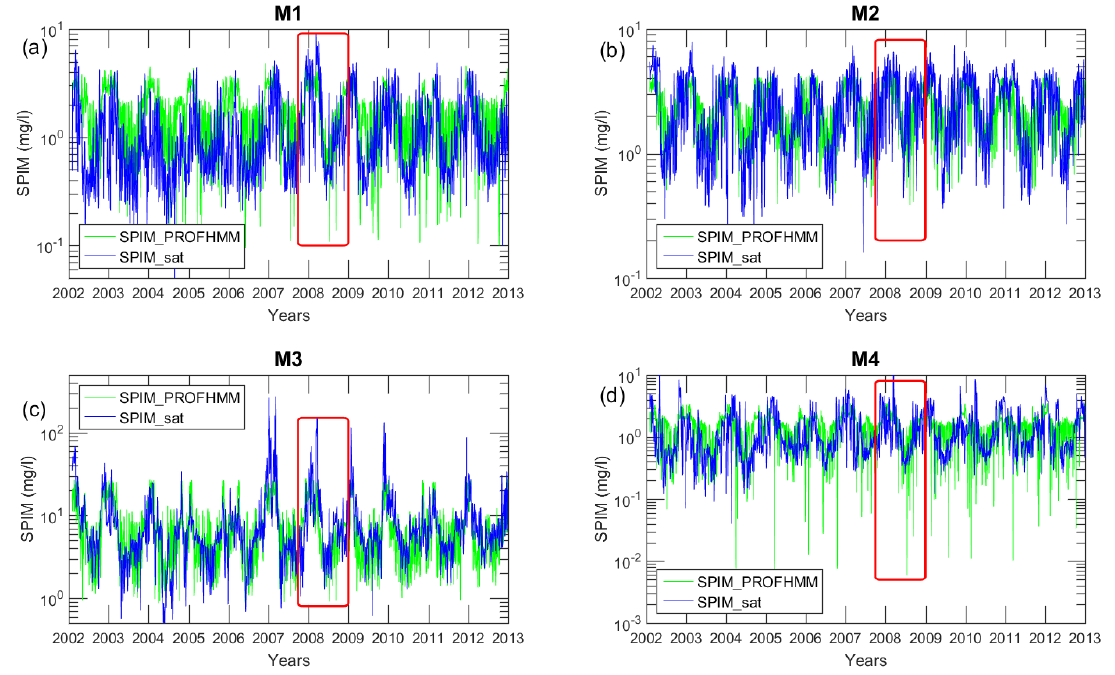
Figure 8. Time series of 25 h running average surface suspended particulate inorganic matter (SPIM) derived through PROFHMM method along with satellite SPIM at station M1 in ( a ), at M2 in ( b ), at M3 in ( c ), and at M4 in ( d ). The breadth of the red colored rectangle indicates the time span of the learning